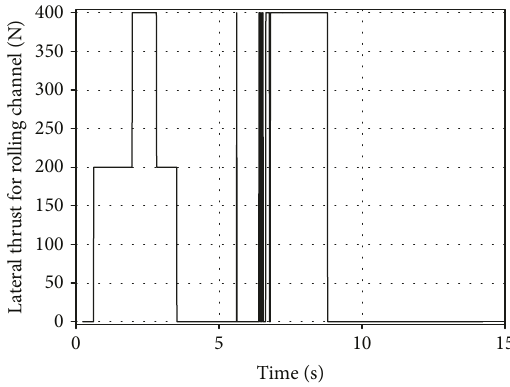
Figure 10: Variation of lateral thrust P